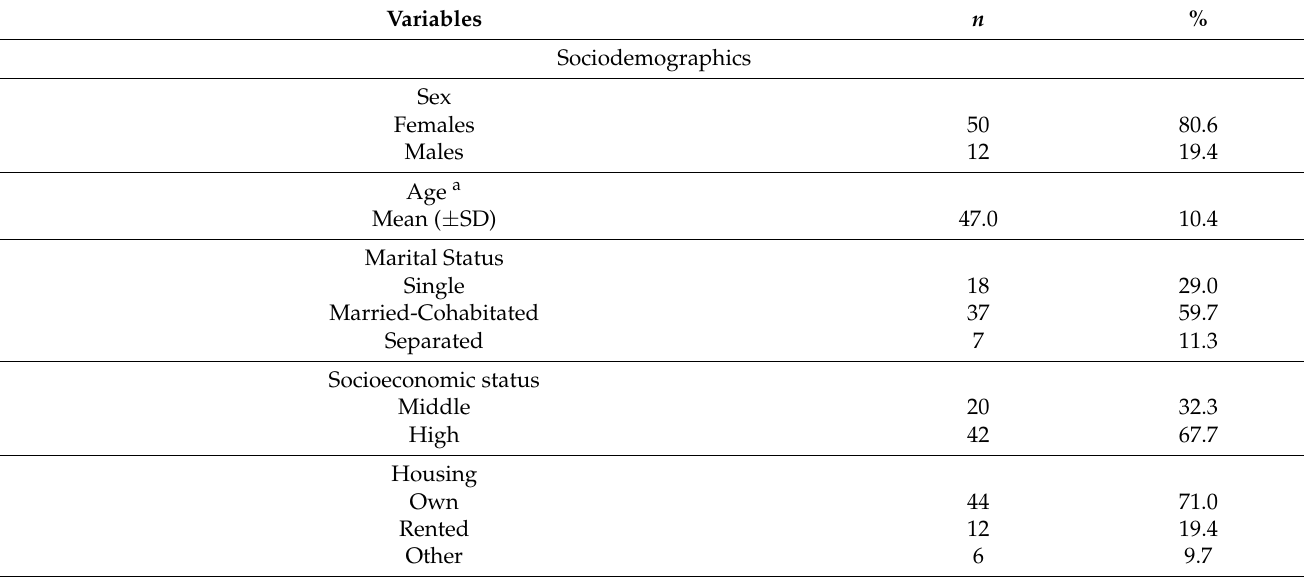
Table 1. Sociodemographic, labor, quality of life and health characteristics of the study population. Medellin, 2021–2022 ( n =